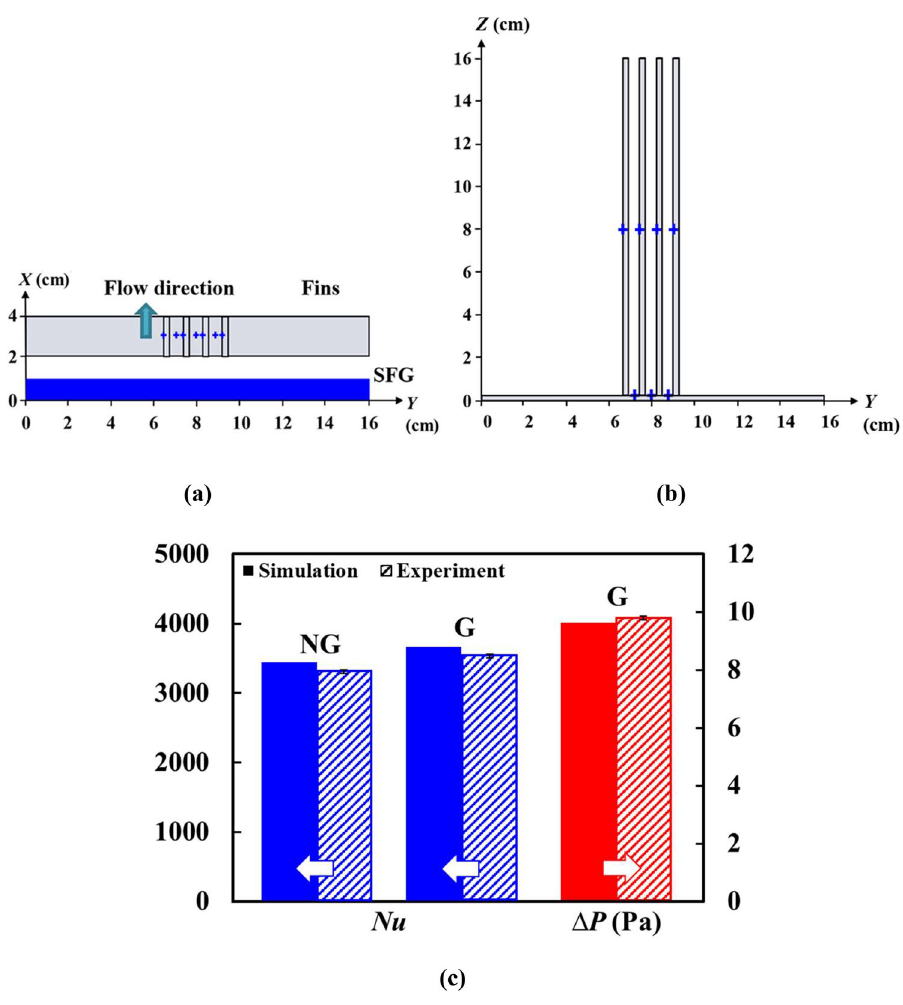
Figure 6. Forced convective heat transfer of Hoi et al.’s 12 numerically optimized N = 3 SFG: the ( a ) top-, ( b ) front-view of the experimentally recoded thermocouple positions on plate-fin heat sink, and ( c ) the experimental verification against Hoi et al. 12 . Note: NG is no grid, and G is with